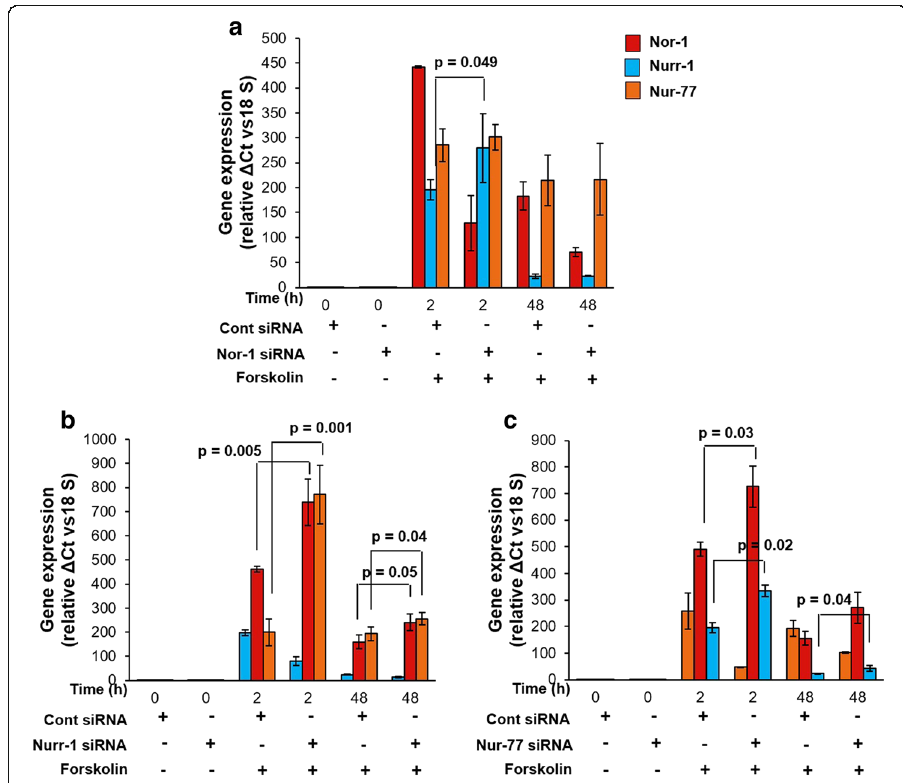
Fig. 4 Transcript profiles of NR4A members in BeWo cells transfected with Nor-1, Nurr-1 or Nur-77 siRNA after forskolin treatment. BeWo cells were silenced for Nor-1, Nurr-1 or Nur-77 using the respective siRNA and transcript levels of all the three members were assessed using qRT-PCR after 0, 2 and 48 h of forskolin (25 μ M) treatment. a , b and c – qRT-PCR analysis of the transcript levels of all three members in BeWo cells with Nor-1, Nurr-1 and Nur-77 knockdown, respectively. Each bar represents the relative expression after normalization with 18S rRNA, expressed as means ± s.e.m. of three independent experiments performed in triplicate. p ≤ 0.05 is considered statistically